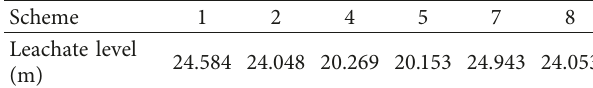
Figure 18: Leachate level in Scheme 2 ( t � 4h). Table 4: Leachate levels of all schemes ( t �